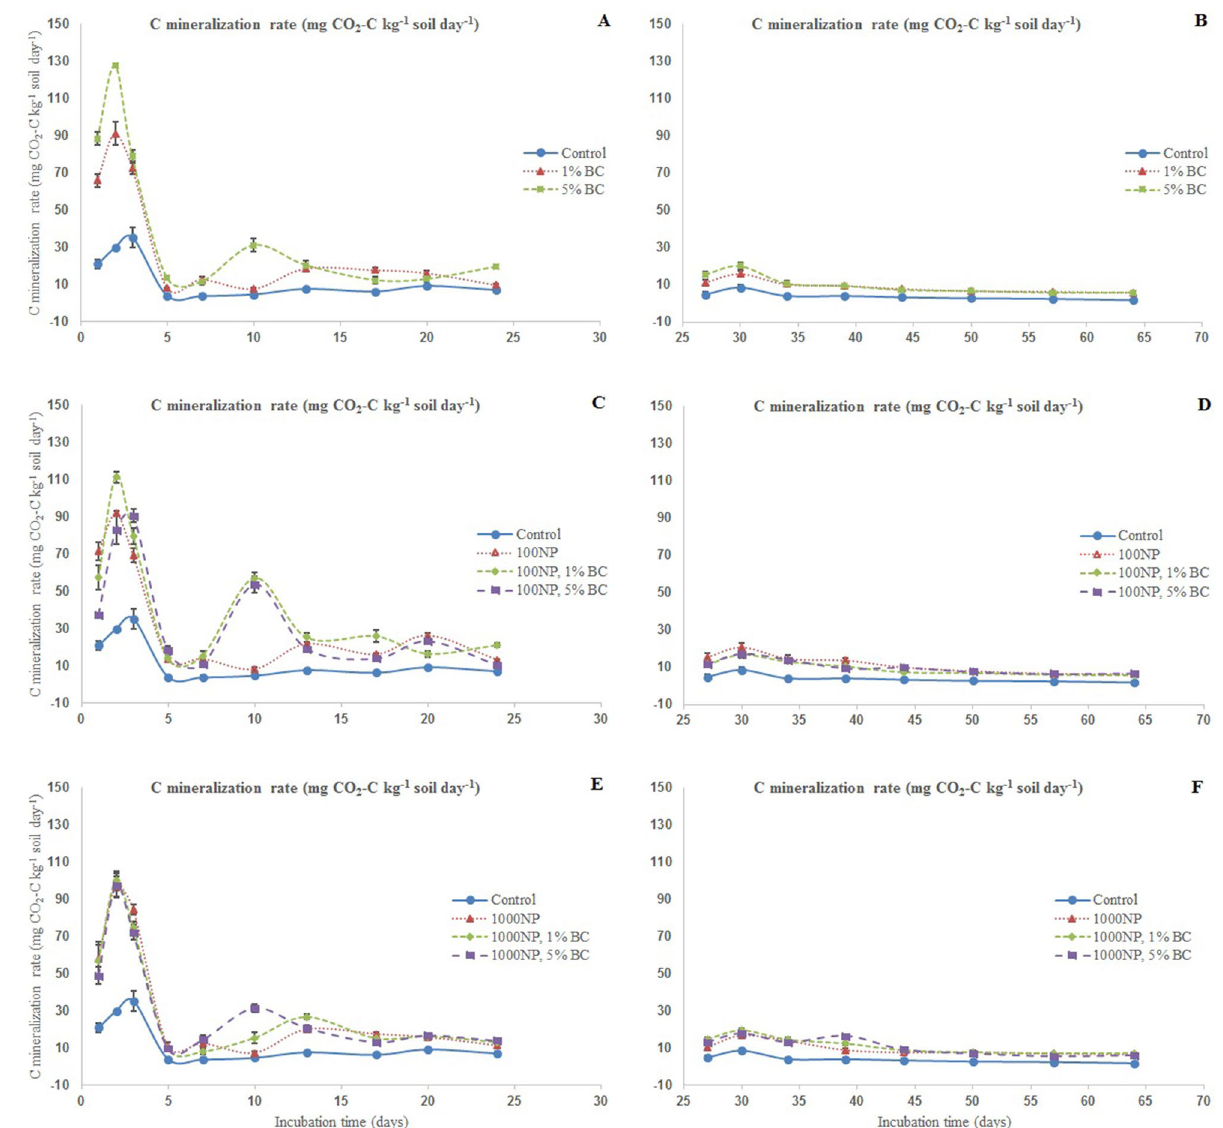
Figure 2. Carbon mineralization rate (mg CO 2 -C kg −1 soil day −1 ) as affected by zinc oxide (nZnO) and rice- straw derived biochar after 24d (panels A , C , E ) & 64d ( B , D , F ) of incubation. C mineralization in different BC, nZnO and BC + nZnO treatments for a given date have been plotted in different panels (e.g. panels A , C , E ) for the purpose of